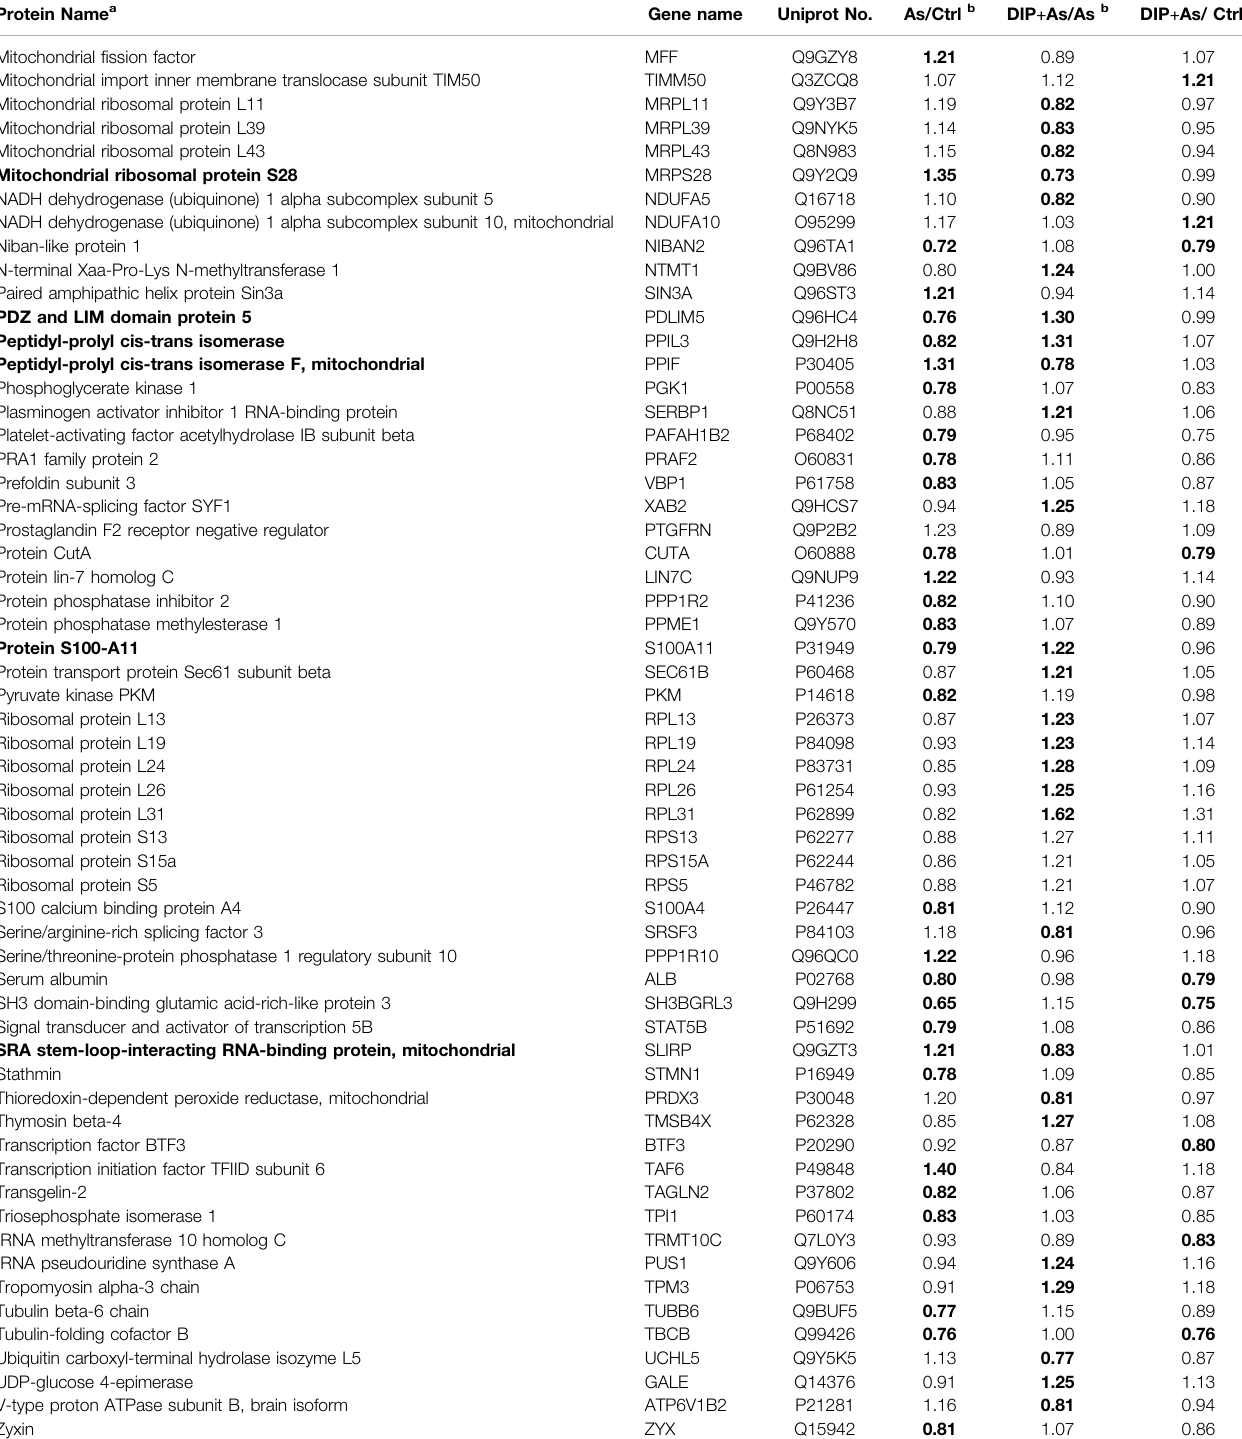
TABLE 1 | ( Continued ) The differentially expressed proteins identi fi ed in different groups in this